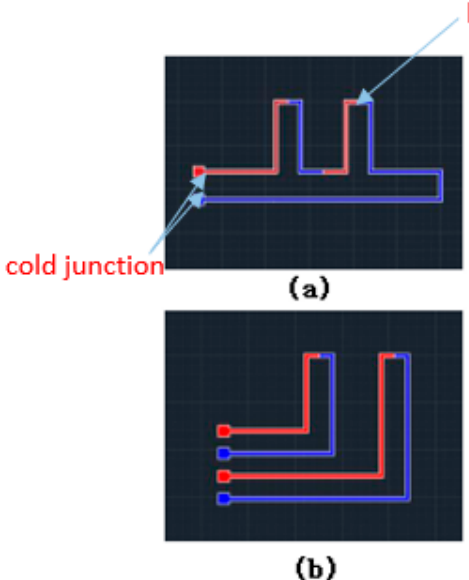
Figure 5. Schematic diagram of sensor position.